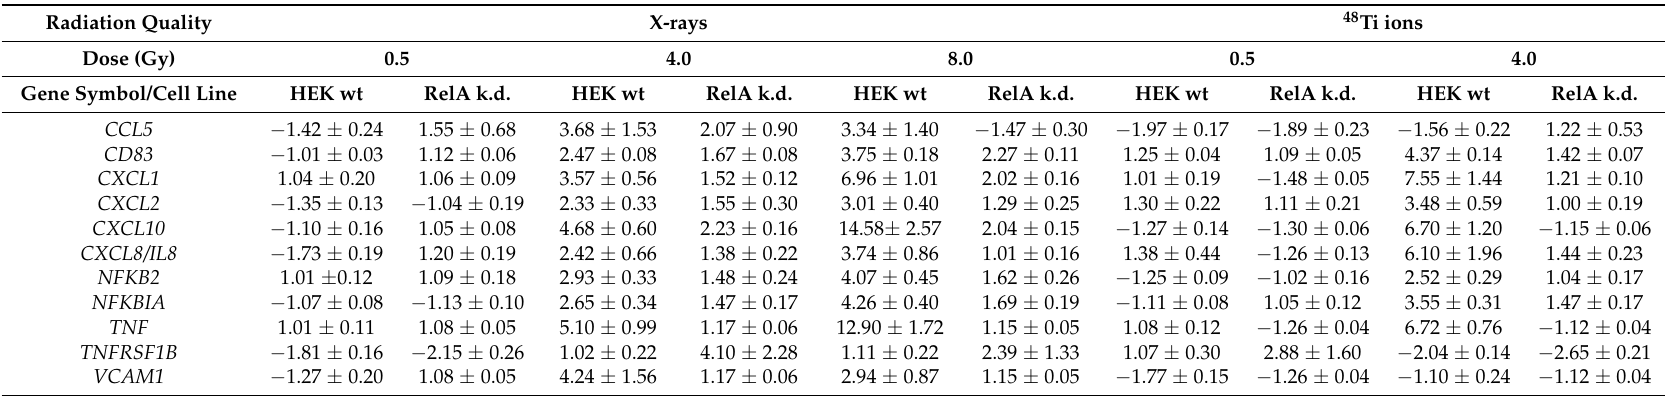
Table 4. Relative gene expression in HEK-pNF- κ B-d2EGFP/Neo L2 (HEK wt) and HEK shRNA RelA (RelA k.d.) cells after irradiation * using the RT2 Profiler PCR array **. The complete data sets are shown in Tables A5 and